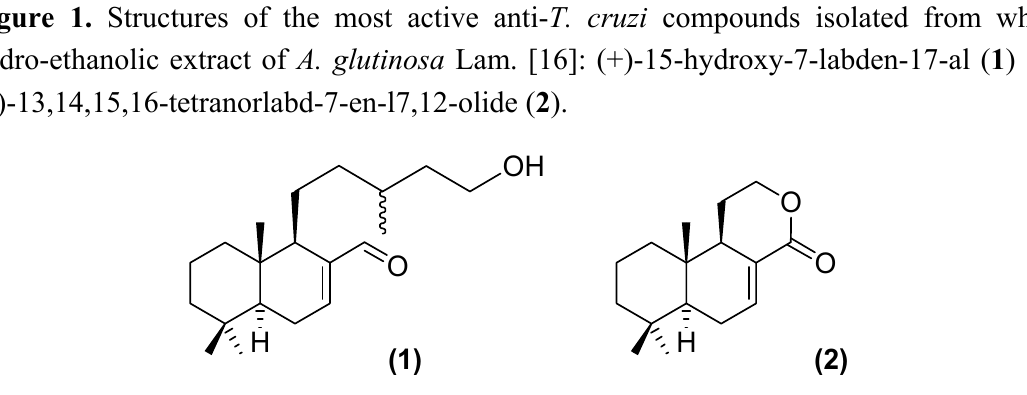
Figure 1. Structures of the most active anti- T. cruzi compounds isolated from whole hydro-ethanolic extract of A. glutinosa Lam. [16]: (+)-15-hydroxy-7-labden-17-al ( 1 ) and